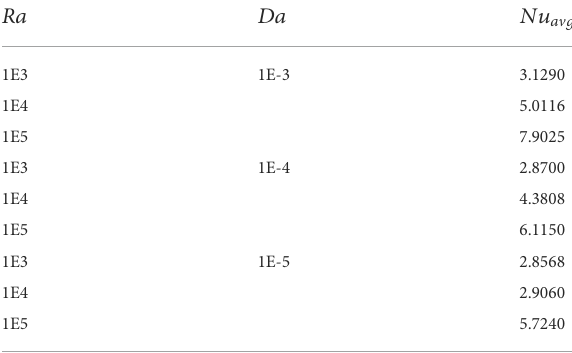
TABLE 3 Variation in the average Nusselt number ( Nu Avg ) against ( Da ) and ( Ra ) . Ra Da